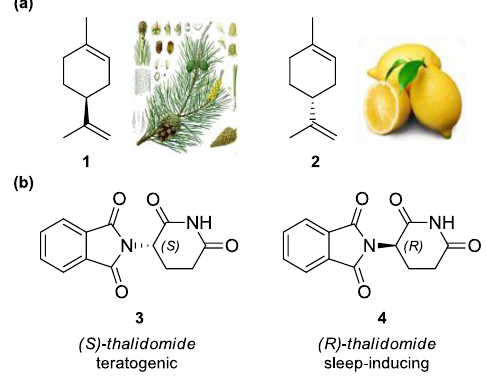
Figure 1. (a) Limonene enantiomers and respective different fragrances: turpentine and lemon; (b) thalidomide, the two